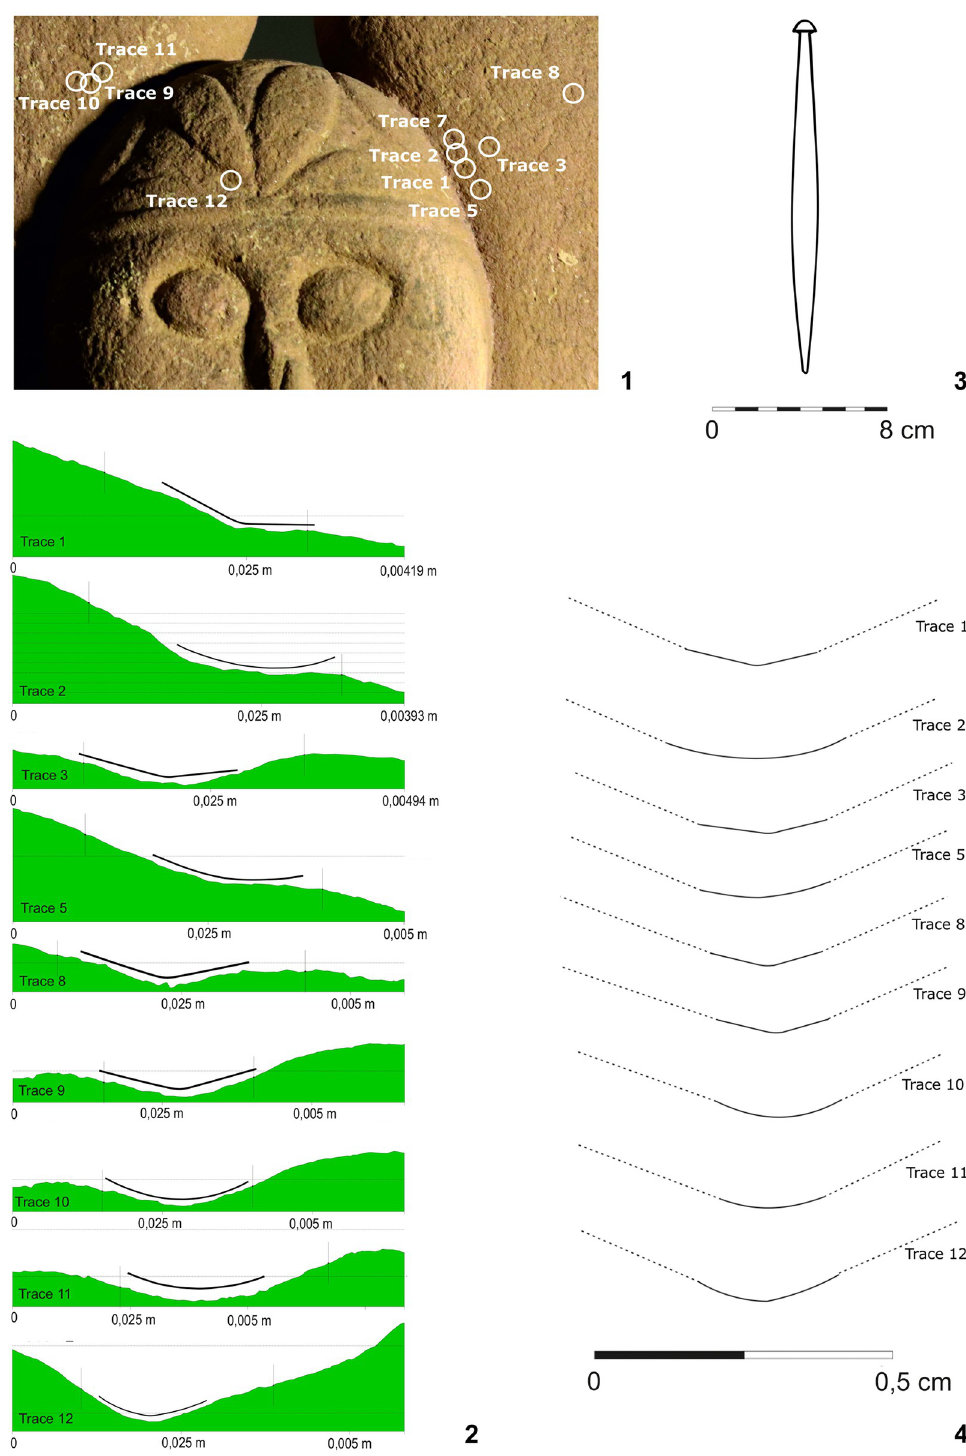
Fig 17. Statue 1 from Glauberg. 1 the traces identified in the head of the sculpture; 2 transverse sections of the selected traces on the head; 3 the reconstructed tool as derived from the identified traces; 4 the changing form of the blade of the tool indicating its sharpening (author: M. Cihla and F. R. Va´clavı´k).